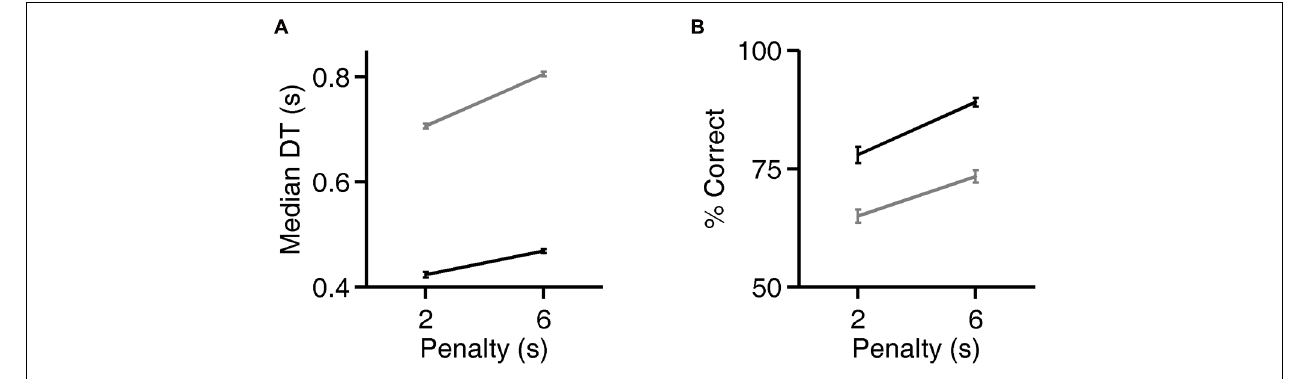
DT is defined as the observed reaction time (RT) minus the rat’s estimated motor latency (lifetime minimum reaction time). This subtracted constant was 0.403 (black) or 0.363 s (gray). For raw reaction time values see Figure 6 . (B) Accuracy of discriminations in the same trials analyzed in panel (A) . Error bars show 95% binomial confidence